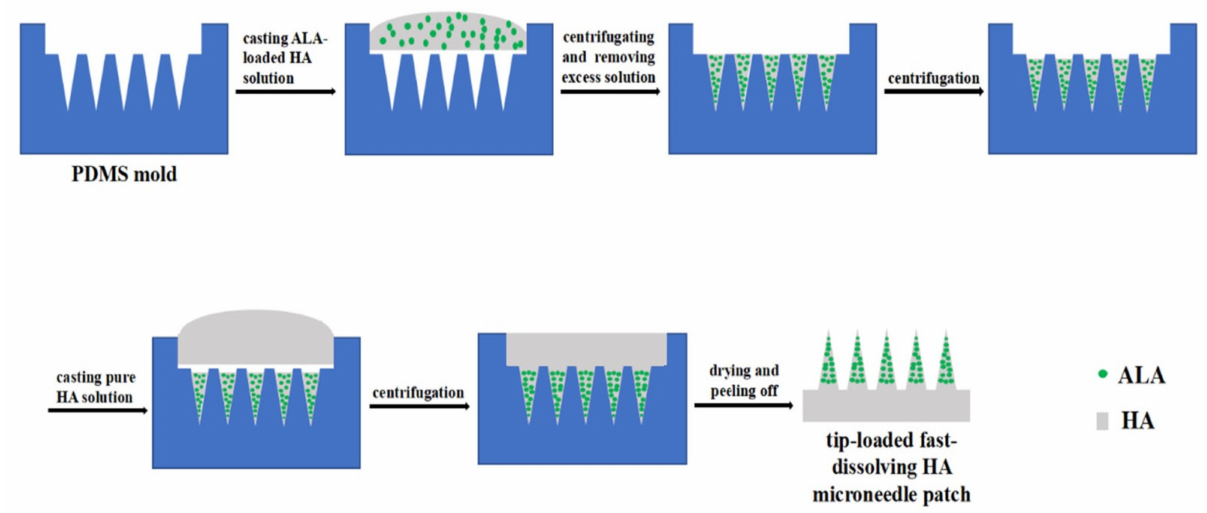
Figure 9. Schematic illustration of the process to fabricate the tip-loaded fast-dissolving HA MN patch [84]. Reprinted from Journal of Controlled Release, Vol. 286, Xiao Zhao et al., Tip-loaded fast-dissolving MN patches for photodynamic therapy of subcutaneous tumor, Pages 201–209, Copyright (2018), with permission from